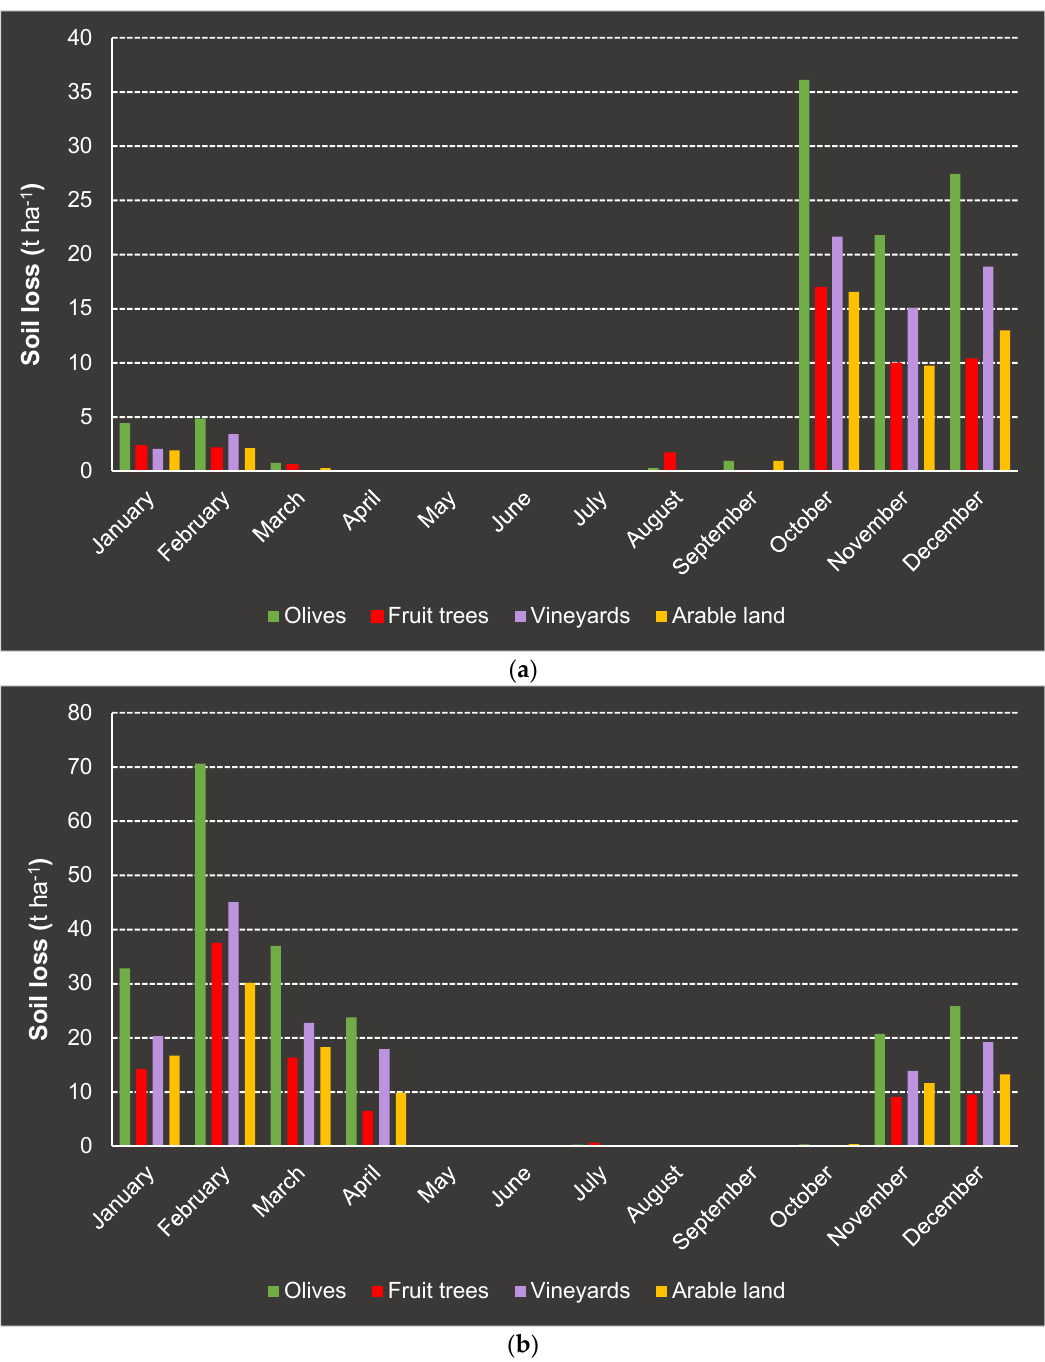
Figure 8. Monthly variation of mean soil loss rate per agricultural land use of Crete Island: ( a ) in 2016; ( b ) in 2019.